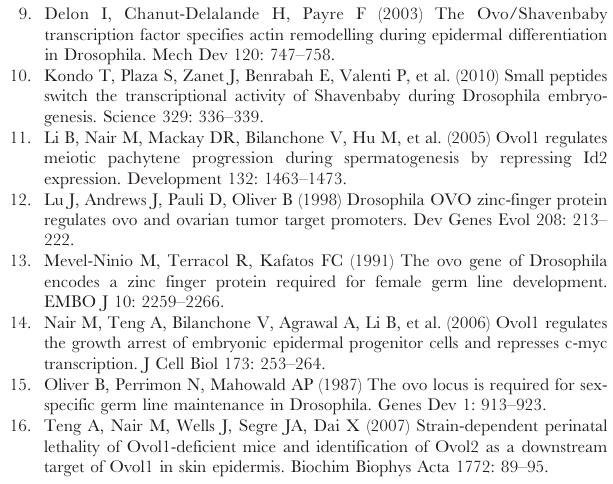
Figure S1 Alignment of OVOL proteins from different vertebrates, B. floridae and N. vectensis. We created this